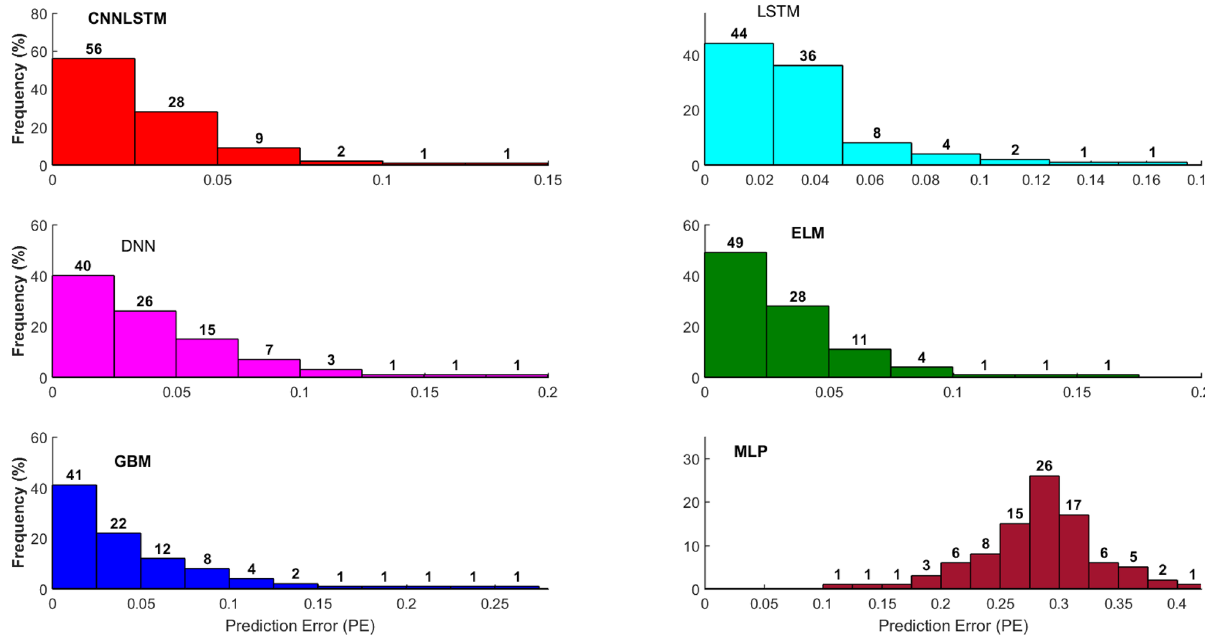
Figure 14. Histogram illustrating the frequency (in percentages) of absolute Prediction errors (| PE |, m 3 s −1 ) of the best performing CNNLSTM model during test period (4-weeks) compared with Long Short-Term Memory Network (LSTM), Deep Neural Network (DNN), Extreme Learning Machine (ELM), Gradient Boosting Regression (GBM) and Multi-Layer Perceptron (MLP) model. for the prediction of hourly streamflow ( Q , m 3 s −1 ) at Brisbane